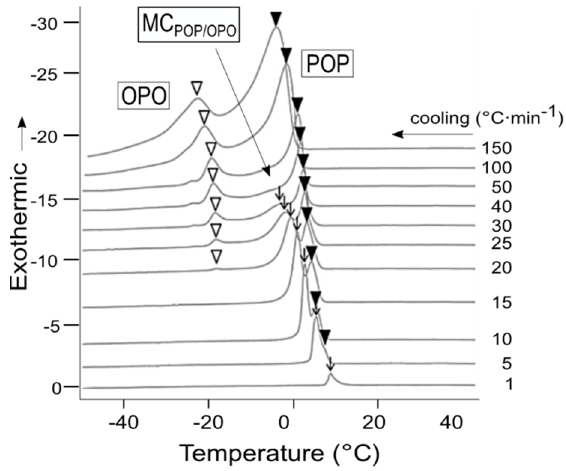
Figure 7. Crystallization behavior of 50POP/50OPO mixtures from low to very high cooling rates. Adapted with permission from [47], © 2018 American Oil Chemist’s Society.